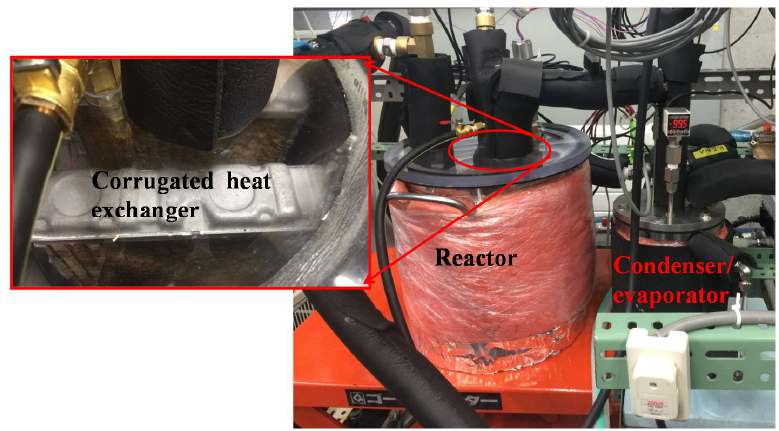
Figure 3. The testing experimental setup for producing cooling energy.